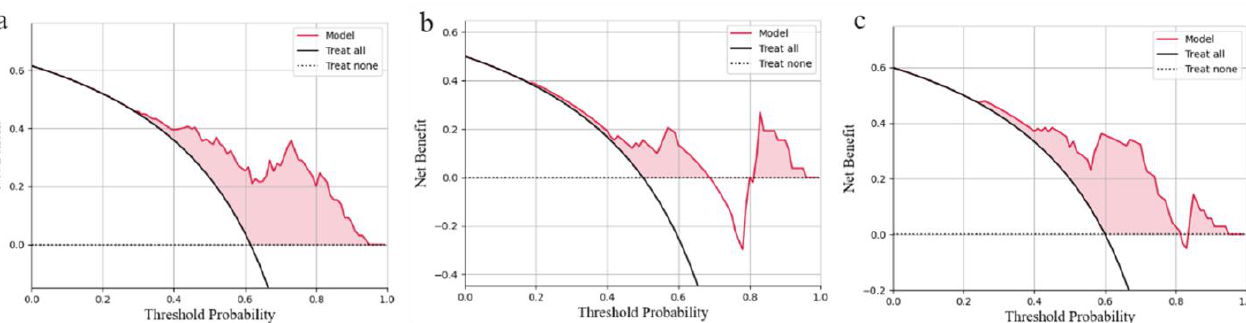
Figure 5. Calibration curve of logistic regression model. Line a: internal test set; Line b: external test set 1; Line c: external test set 2.